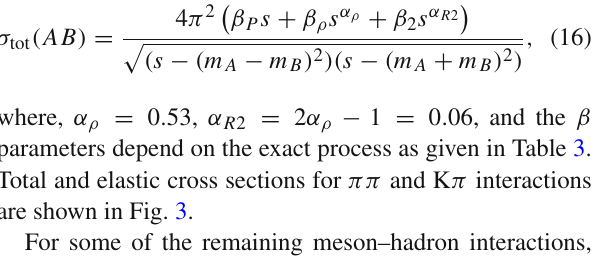
Fig. 3 Total and elastic cross sections for ππ and K π interactions. We see that resonances exist for π + π − and K + π − , but not for π + π + and K + π + . The elastic cross sections include cross sections for elastic scattering through a resonance. For π + π − , the elastic data comes from Refs. [59,60], while total data comes from Ref. [61] in the 0.3–1.4 GeV range and from Refs. [62,63] in the 1.25–2.5 GeV range. We see here that the cross section in the energy range around 1.0–1.4 GeV does not fit very well with the data from Ref. [61]. Other frameworks like